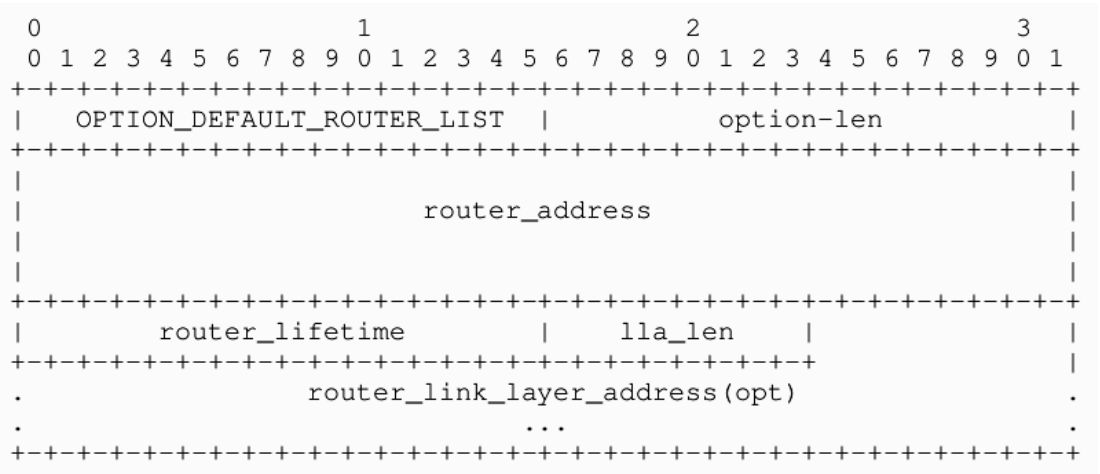
Figure 7. DHCPv6 default router list option fields. This option is used by the server to answer option request option (ORO) option sent by the